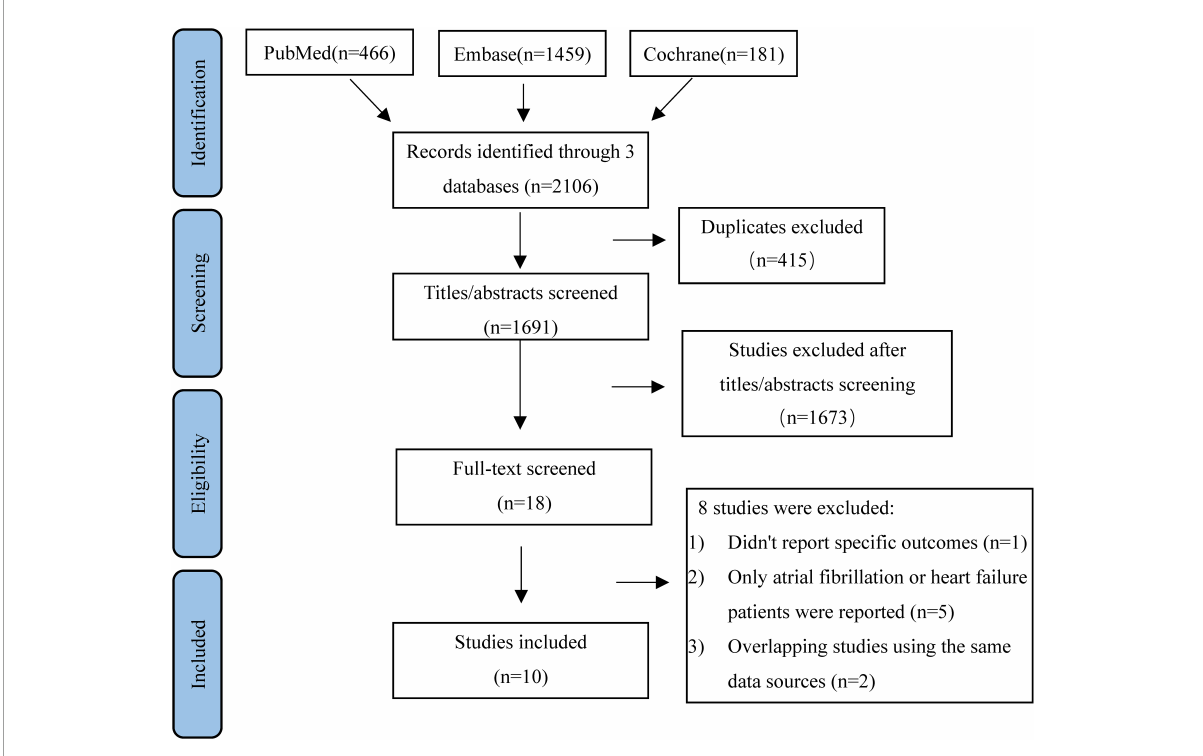
FIGURE1 Flowchart of studies identified, screened, excluded, and included in the